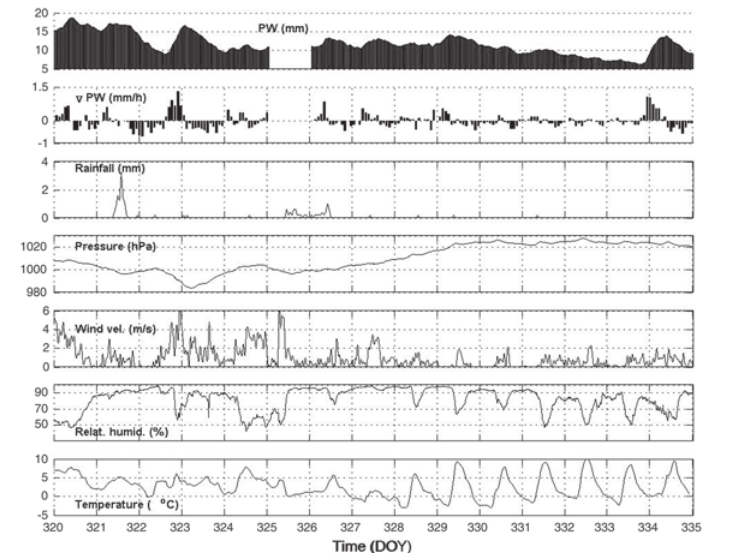
Fig. 5. Precipitable Water (PW, mm) and PW curve derivative coefficient sign ( ∇ PW, mm/h) for Padua; barometric pressure (hPa); wind velocity (m/s); relative humidity (%) and air temperature at 2 m ( ° C) for Verona versus time for period of DOY 320-335, 16 November - 01 December,